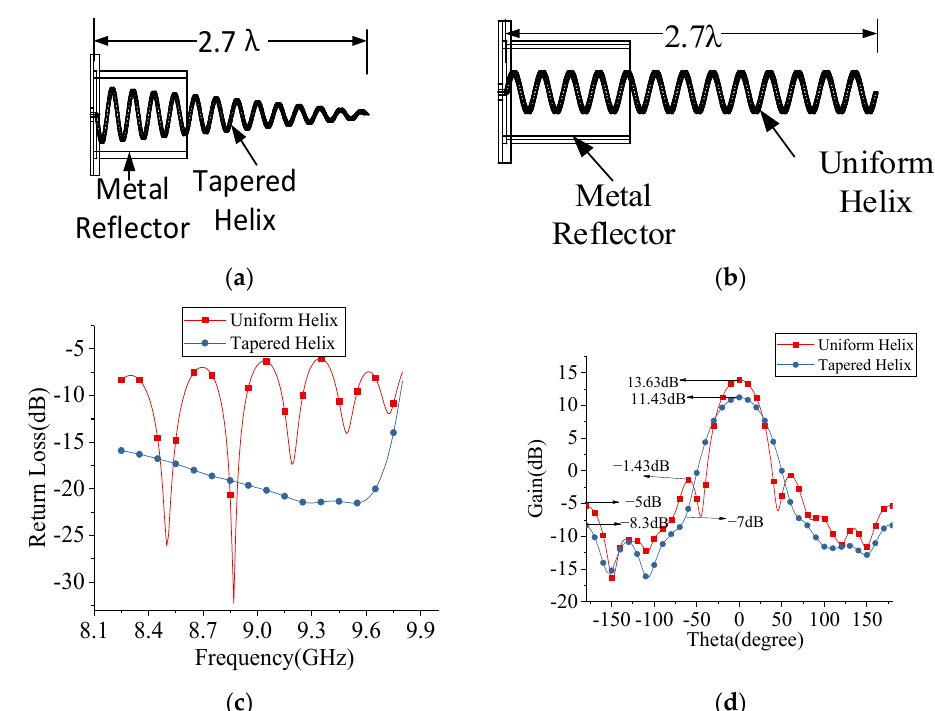
Figure 3. ( a , b ) Gives the schematic of tapered helix and uniform helix with metal reflector ( c ) Band- width comparison of tapered and uniform helix. ( d ) The gain and side lobe level comparison with tapered and uniform helix.